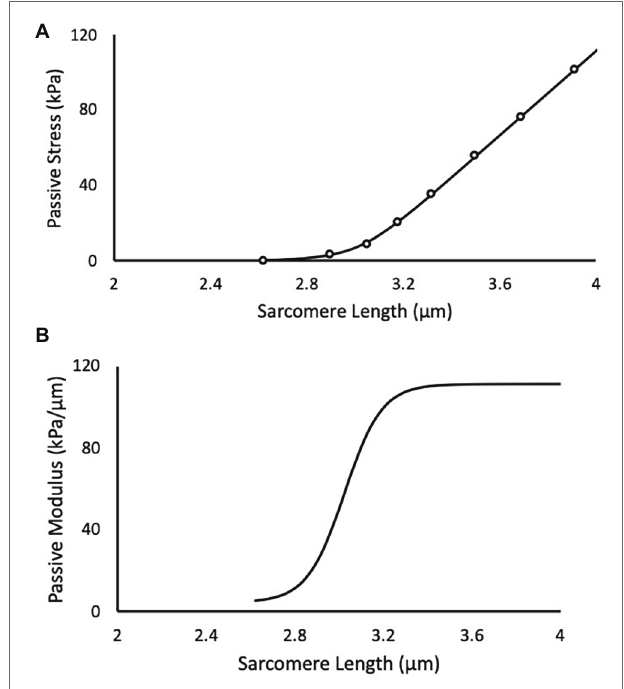
FIGURE 1 | A representative experimental test of a muscle fiber bundle is depicted in black. (A) Scatter points are experimental data and solid line is the predicted fit of the logistic integral. (B) The corresponding passive elastic modulus-sarcomere length (SL) relationship for the